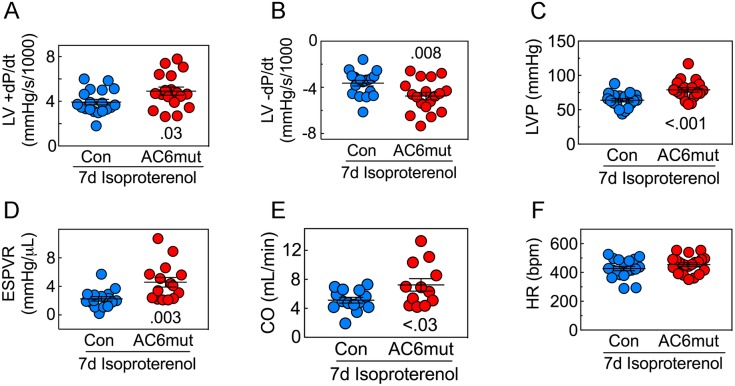
LV function.A. After seven days of continuous isoproterenol infusion, mice with cardiac-directed AC6mut expression exhibited a 25% greater LV peak +dP/dt (p = 0.03), indicating increased LV systolic function. B. LV peak -dP/dt was also superior in mice with cardiac-directed AC6mut expression (31% increase, p = 0.008), indicating increased LV diastolic function. C. LV developed pressure also was superior in mice with cardiac-directed AC6mut expression. D. The slope of the LV end-systolic pressure-volume relationship (ESPVR), a load-independent measure of LV contractility, was also 2-fold steeper in mice with cardiac-directed AC6mut expression (p = 0.003) E. Cardiac output was 41% higher in AC6mut mice (p<0.03). F. Heart rate showed no group difference. Data are from individual animals, collected without knowledge of group identity; mean±SE are also indicated; p value from Student’s t-test, unpaired, 2-tailed.